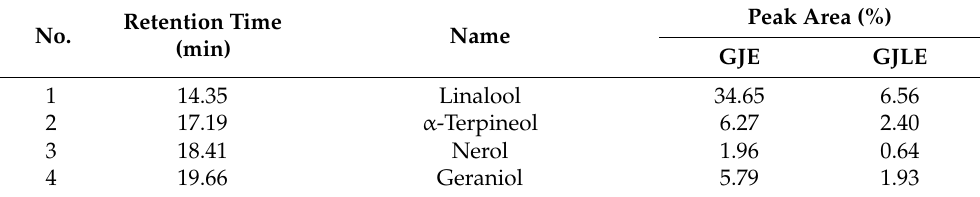
Table 1. The main constituents of the essential oils of the two gardenia